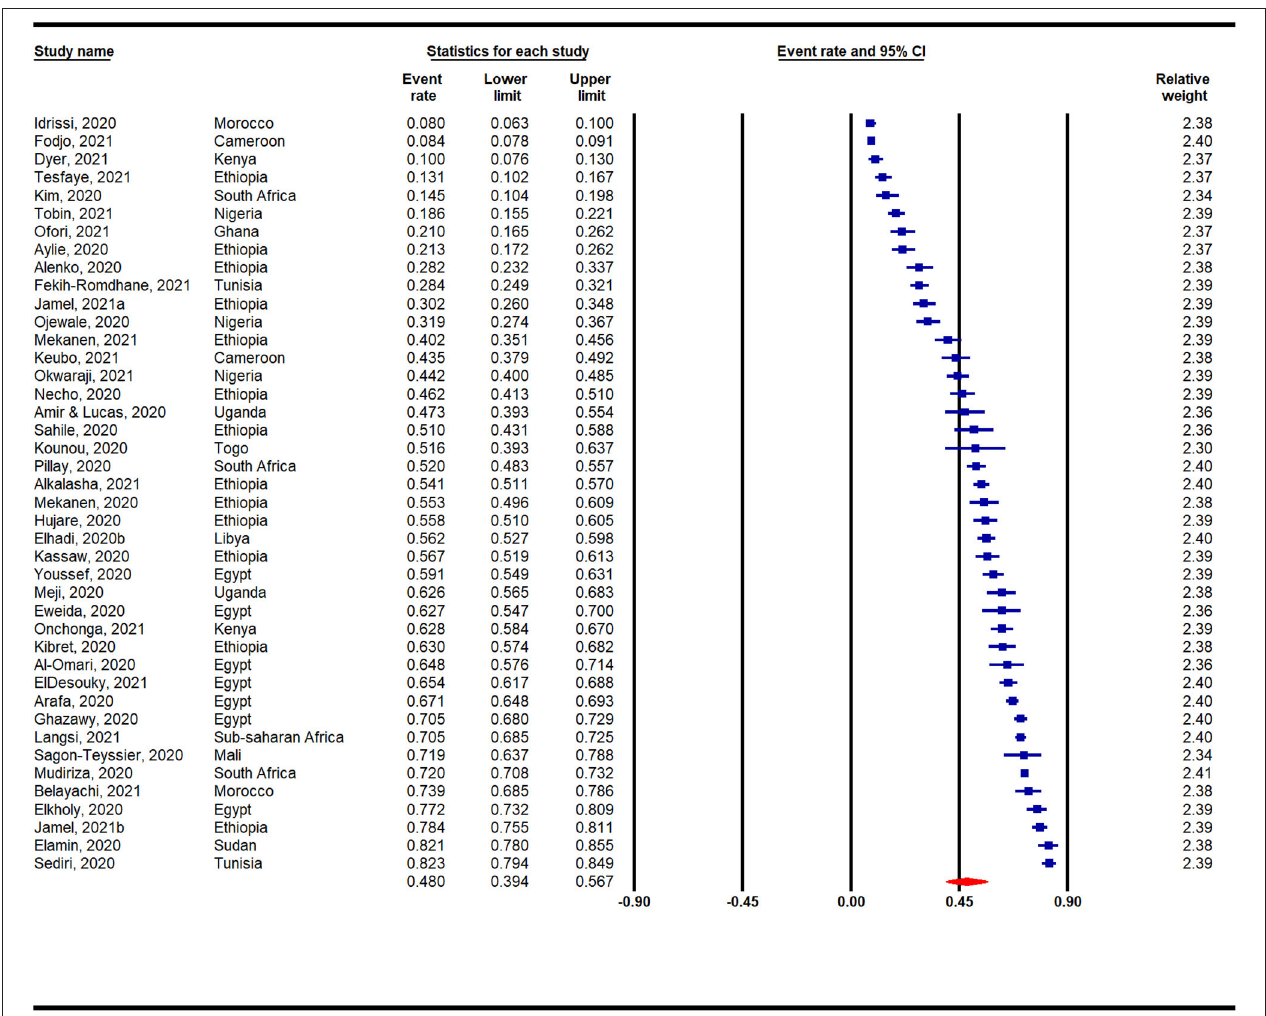
FIGURE 5 | Overall prevalence of depression in Africa during the COVID-19